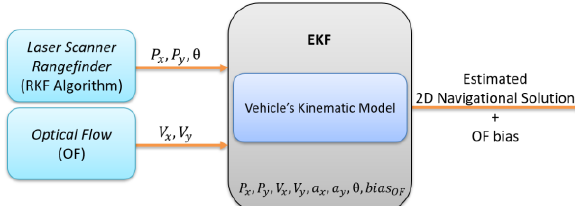
Figure 2. System architecture diagram of the estimation of the